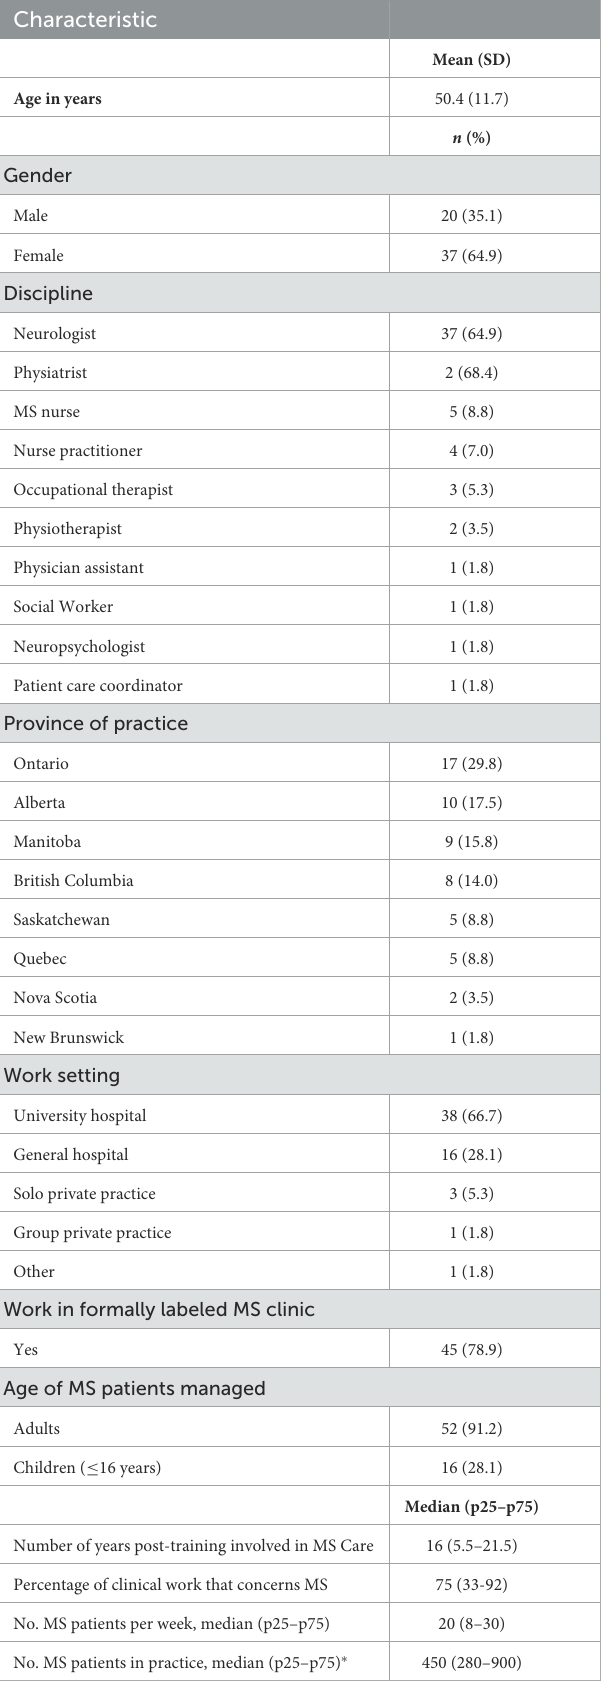
TABLE 1 Characteristics of respondents, stratified according to whether practice includes people with multiple sclerosis ( N = 57).